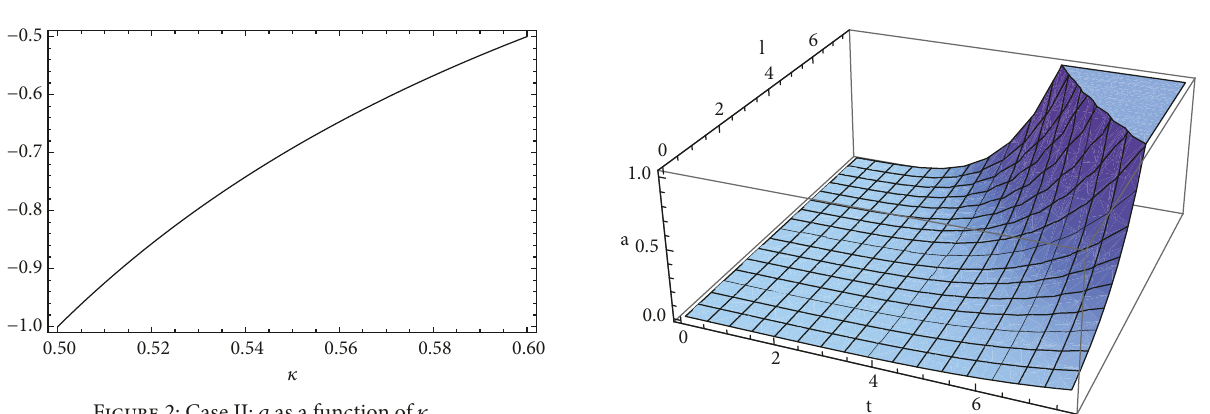
From Figure 3, one can note that the value of 𝑙 , i.e., the length scale of the extra coordinate, has a profound influence on the evolution of the scale factor. One realizes that the smaller the value of 𝑙 , the greater the age of the universe, which is the value of 𝑡 for 𝑎(𝑡, 𝑙) = 𝑎 0 = 1 (the present value of the scale factor [52]). According to